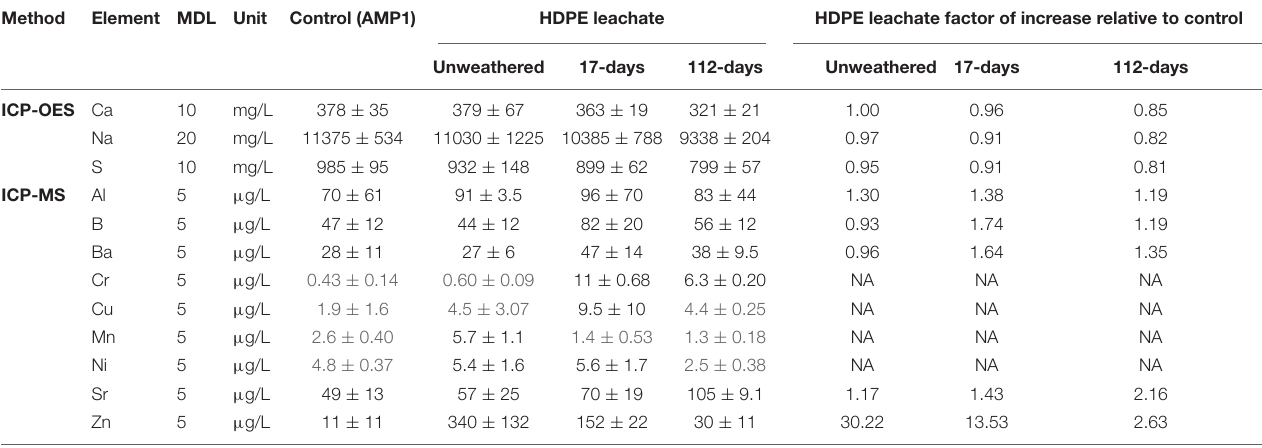
TABLE 1A | Concentrations of selected elements in unweathered and weathered (17- and 112-days) HDPE leachates AMP1 and control media detected by ICP-OES and ICP-MS, and their factor of increase in leachates relative to control. Method